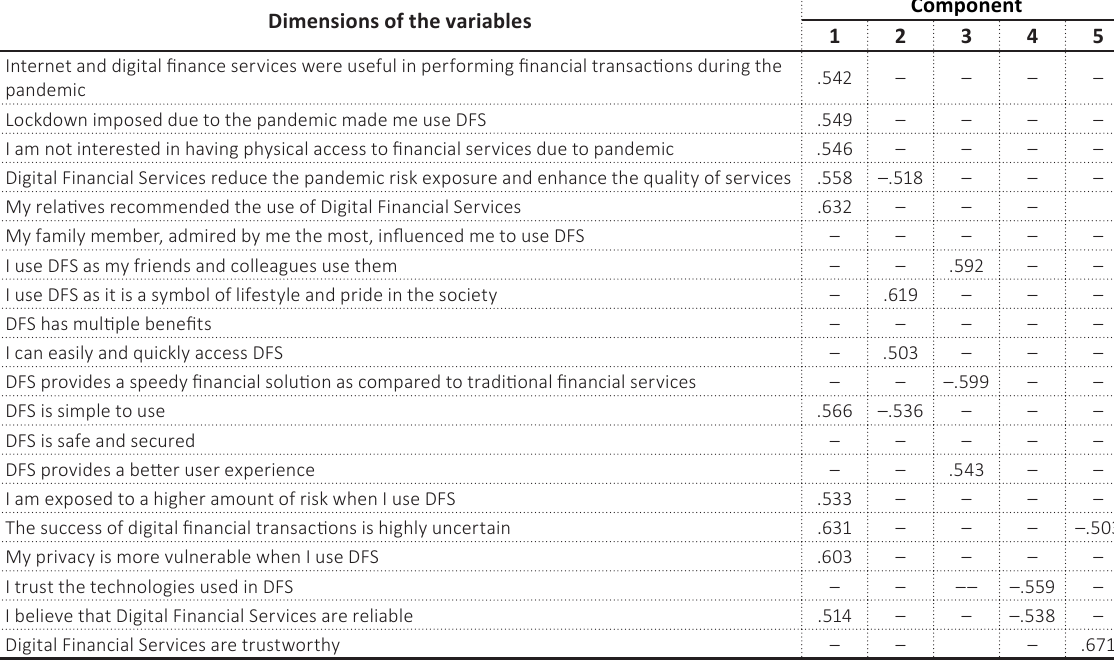
Table A1. Loadings of five variables on five factors extracted. Component matrix Dimensions of the